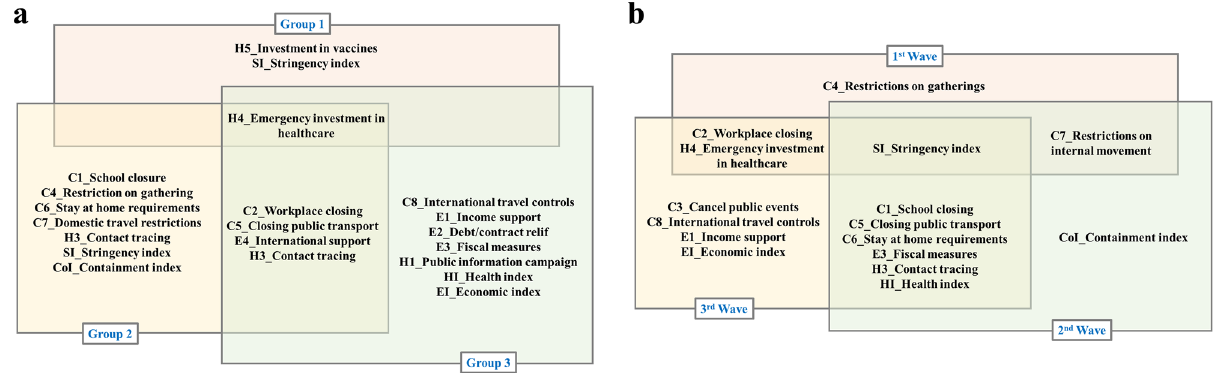
Figure 4. Venn diagram of significant policies at all time lags. ( a ) Significant policies and indices from subgroup analysis and ( b ) show significant policies and indices from the wave-specific analysis at all-time